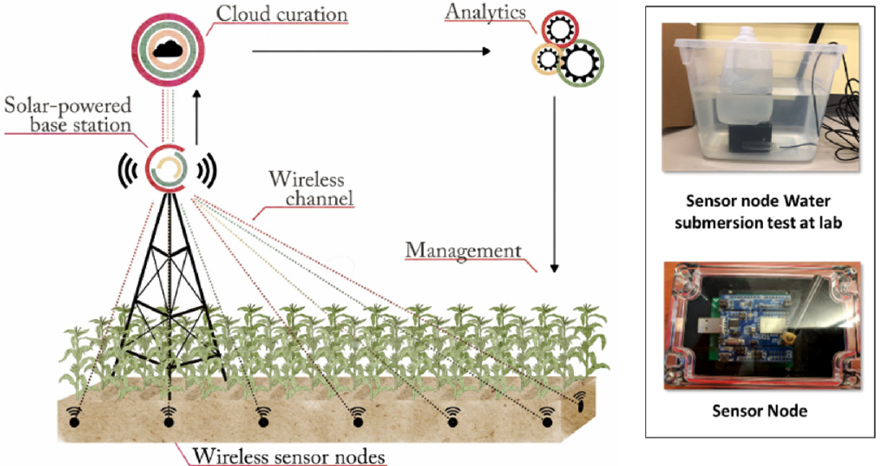
Figure 1. The wireless underground sensor network Thoreau 2.0 design. Inset shows sensor node and water submersion test conducted in the laboratory prior to field deployment.